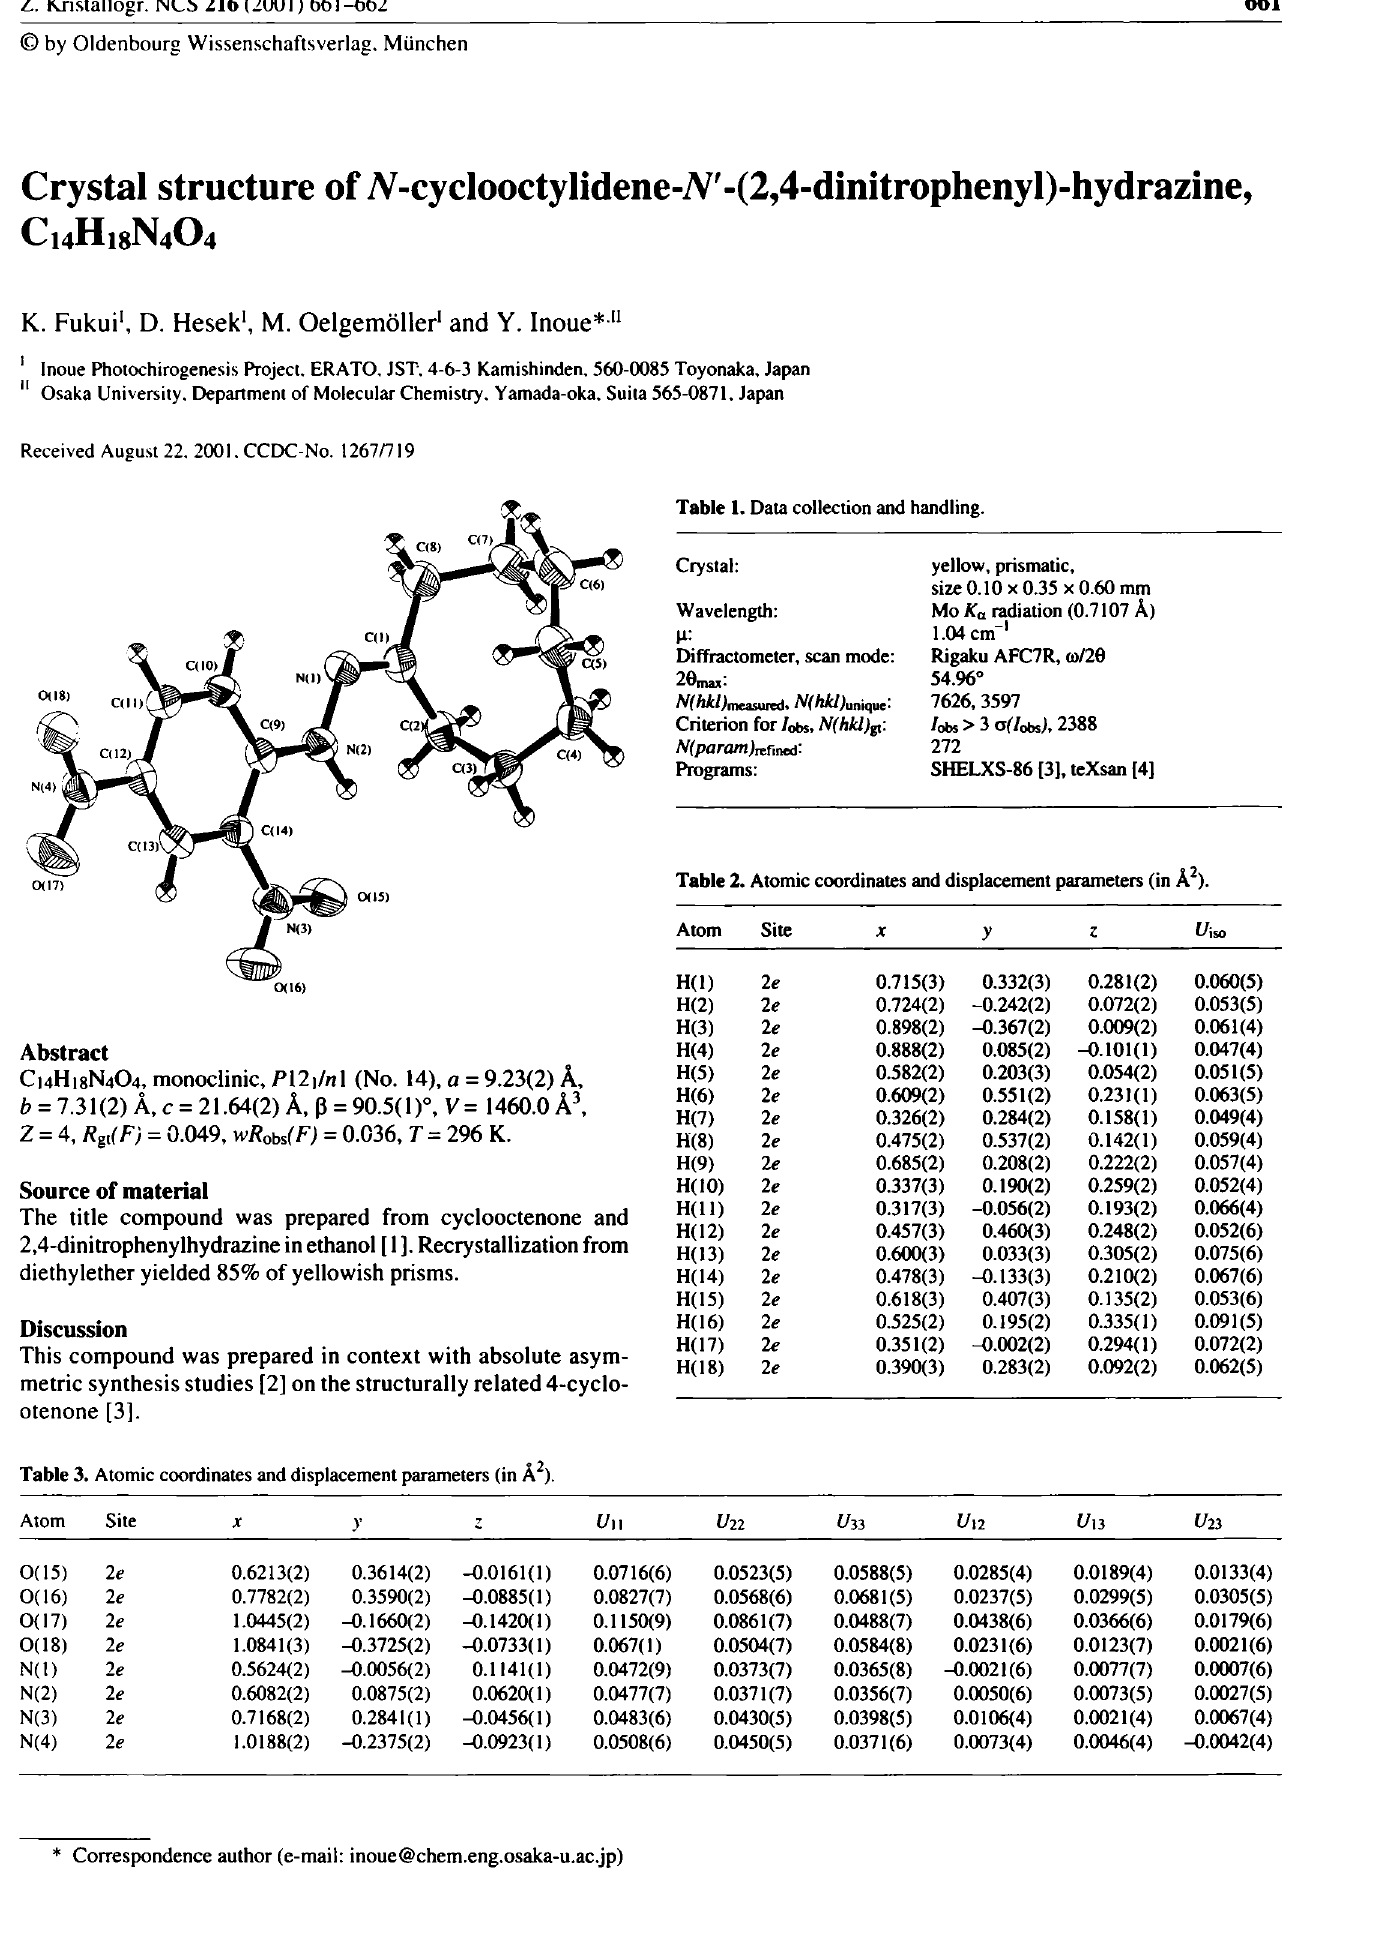
Table 3. Atomic coordinates and displacement parameters (in A 2